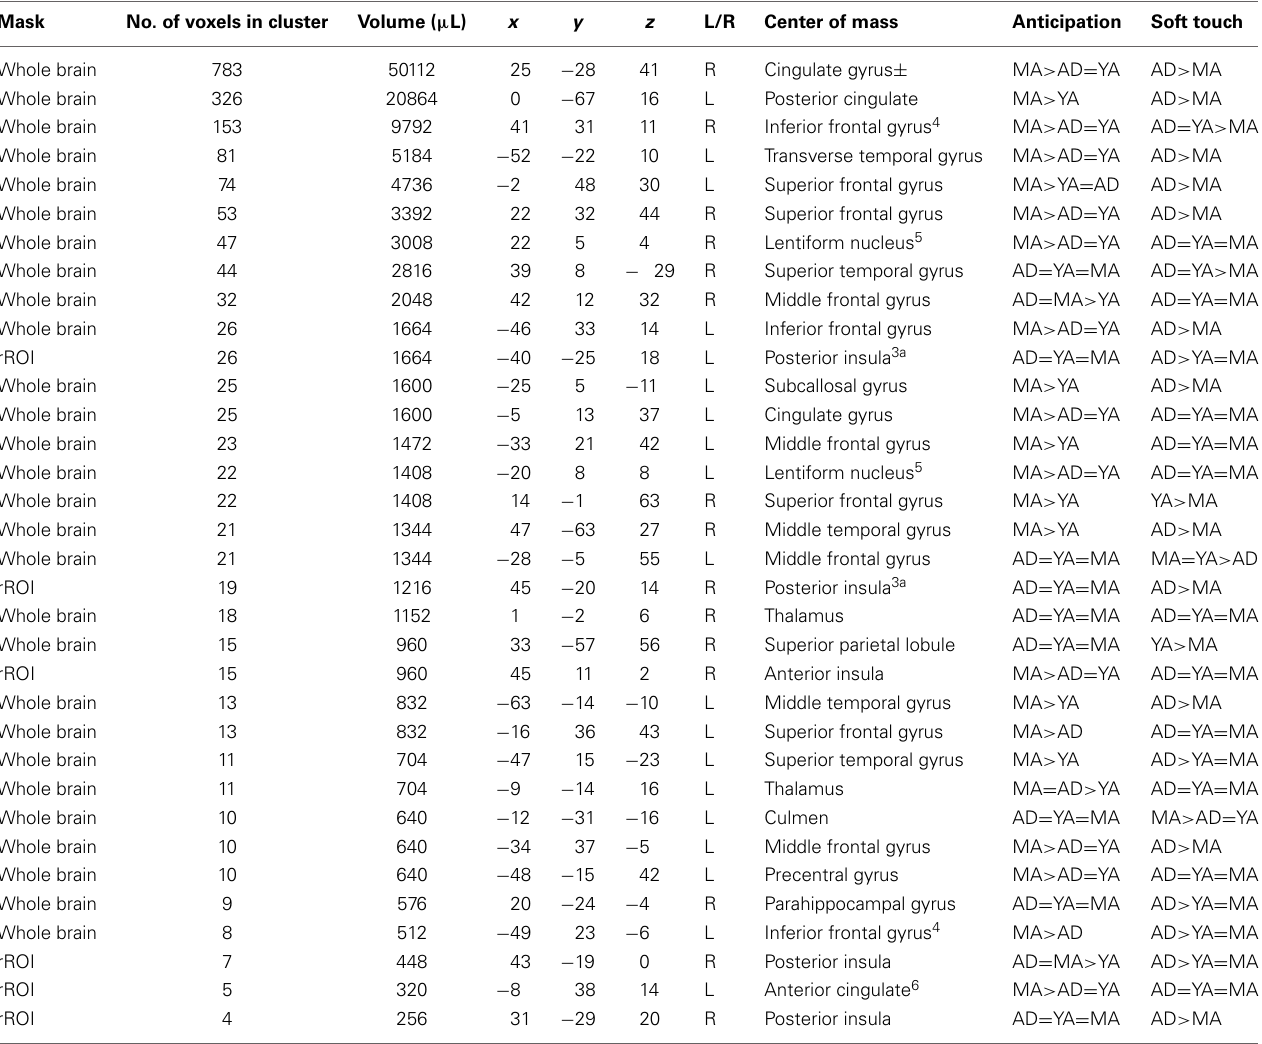
Table 4 | fMRI results for group by condition